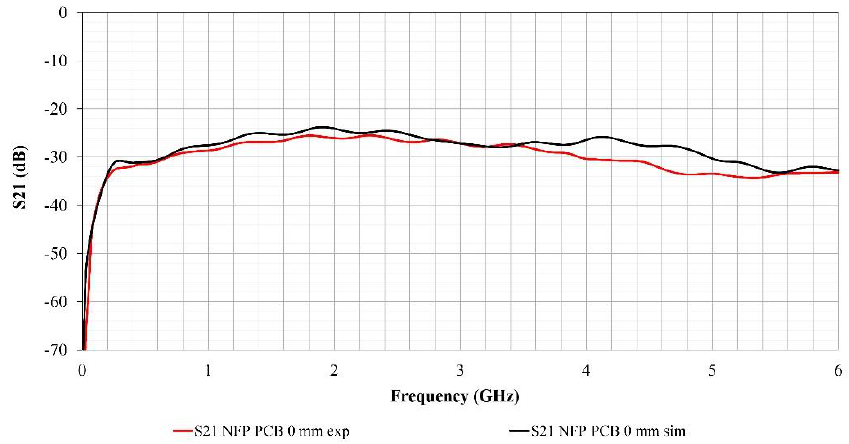
Figure 10. Comparison of the NFP-PCB S 21 parameter obtained by FEM simulation and experimen- tally measured.